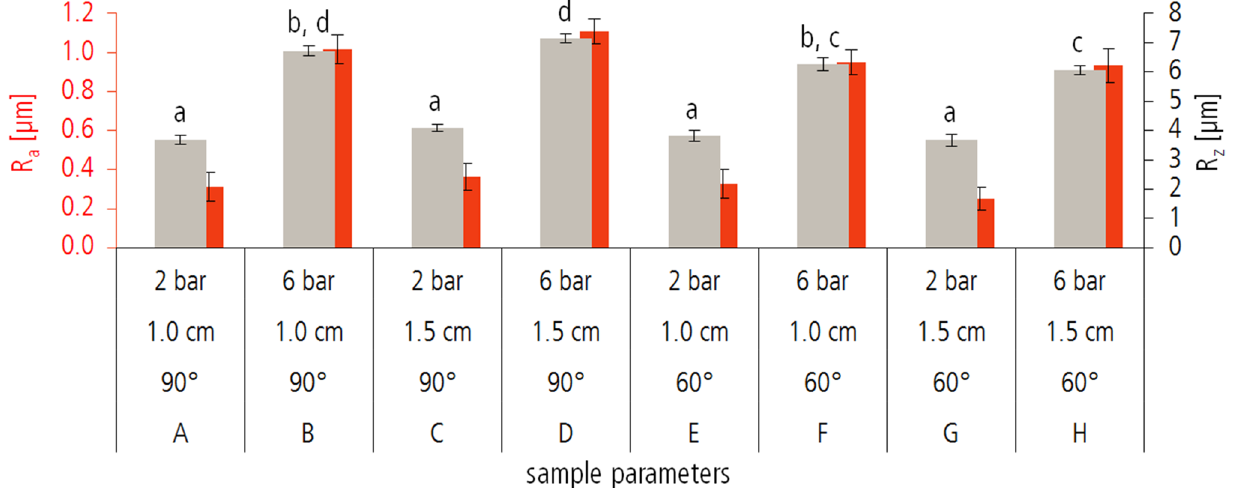
indicate groups with non-significant differences (p > 0.05) between and R of selected parameter a z their mean values. Without sandblasting the surface roughness val- ues were R = 0.01 µm ± 0.00 µm and R = 0.12 µm ± 0.01 a z